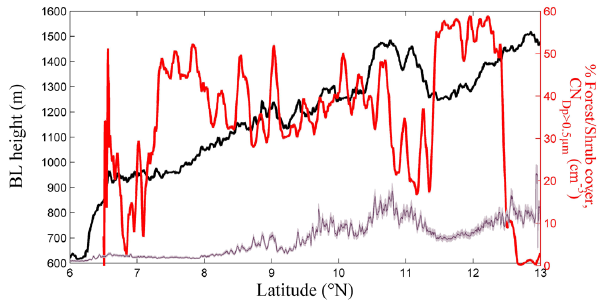
Fig. 9. Calculated boundary layer top (black line) at 12:00UTC on 13 June and fraction of forest/shrub cover as derived from the GlobCover Land Cover map (red line) as a function of